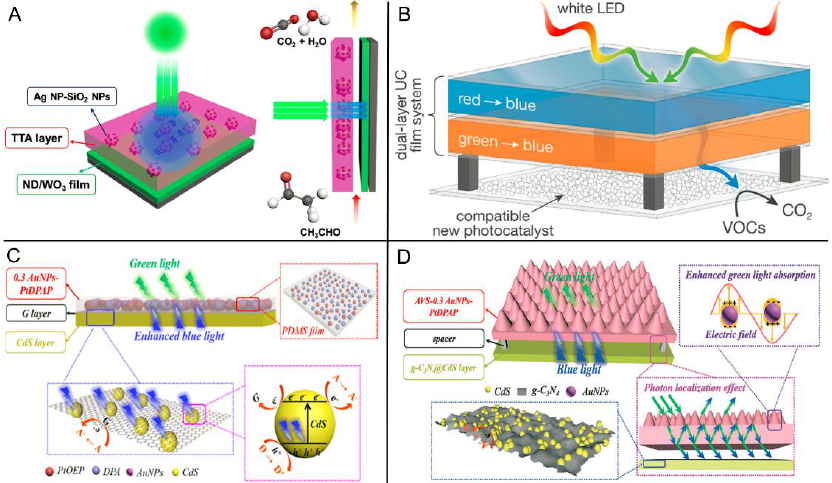
Figure 8. ( A ) Schematic representation of the plasmon-enhanced sub-bandgap photocatalysis via TTA-UC for acetaldehyde degradation. Reprinted with permission from ref. [113]. Copyright 2016